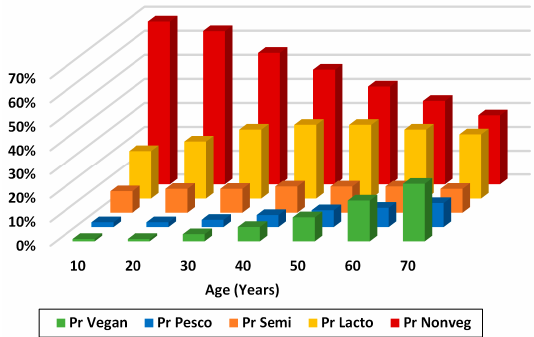
Figure 3. Proportions (Pr) in different dietary categories at different ages—longitudinal analysis in AHS-2 adjusted for birth cohort and other covariates. Reported here is the reference cohort who enrolled in AHS-2 in their 60s (Nominal multinomial analysis. pr non-veg: pr non vegetarians, pr lacto: lacto-ovo vegetarians, pr vegan: vegans, pr semi: semi vegetarians, and pr pesco: pesco vegetarians; N = 51,082). Other variables in the model are: diet age, race, gender, education, birth cohort.